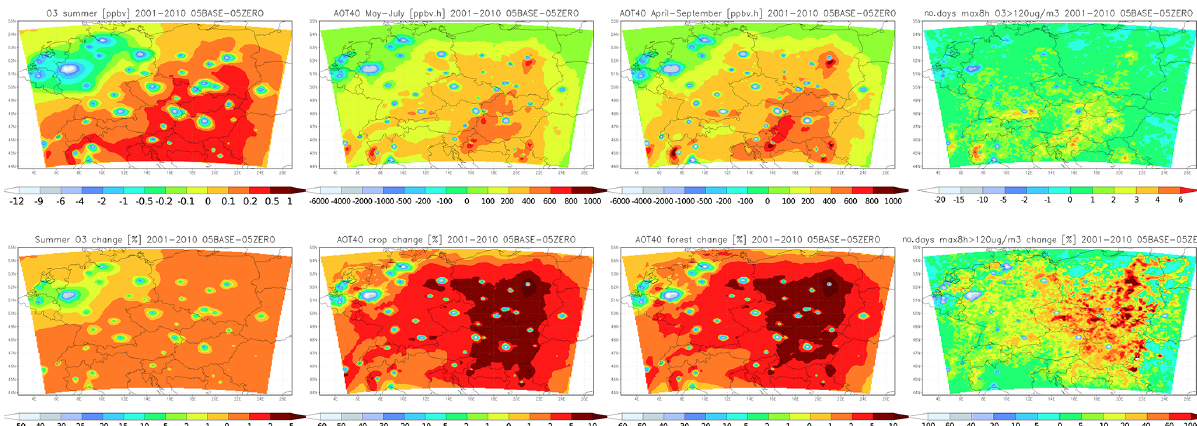
Figure 6. Impact of city emissions on ozone related air quality measures listed in Table 4. Upper row presents the absolute change averaged over 2001–2010. The lower row corresponds to the change relative to the zero urban emission case (05ZERO).